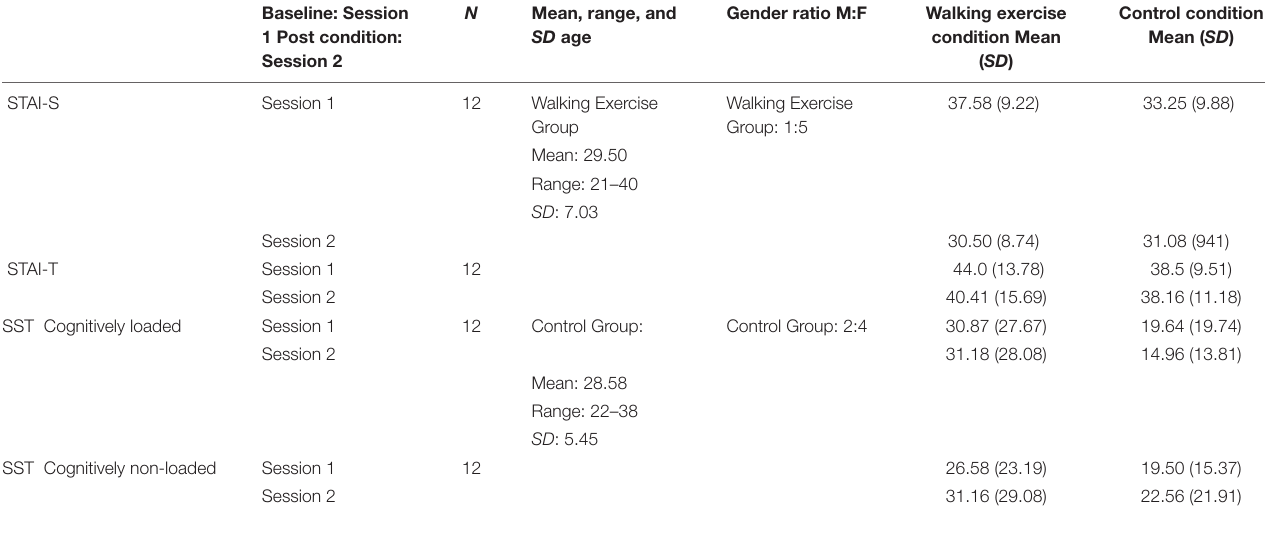
TABLE 1 | Study 1: Mean and standard deviation for walking and control condition for STAI and SST